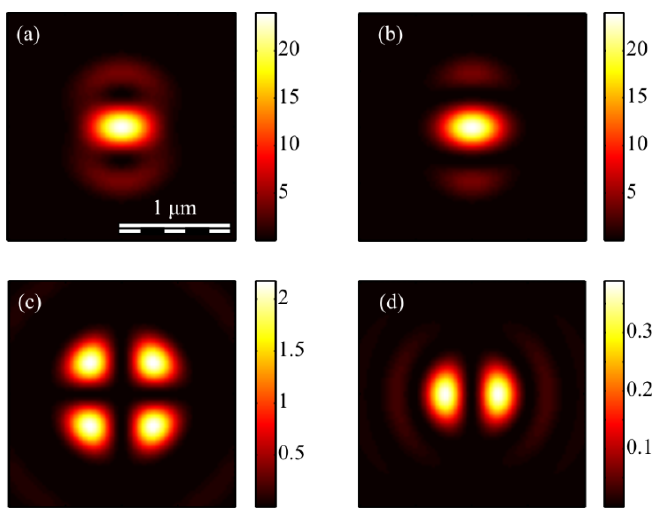
Figure 4. The intensity I ( a ) and its components I x ( b ), I y ( c ) I z ( d ) of the focused vector field (1) of the second ( m = 2) order with a = 1/2.